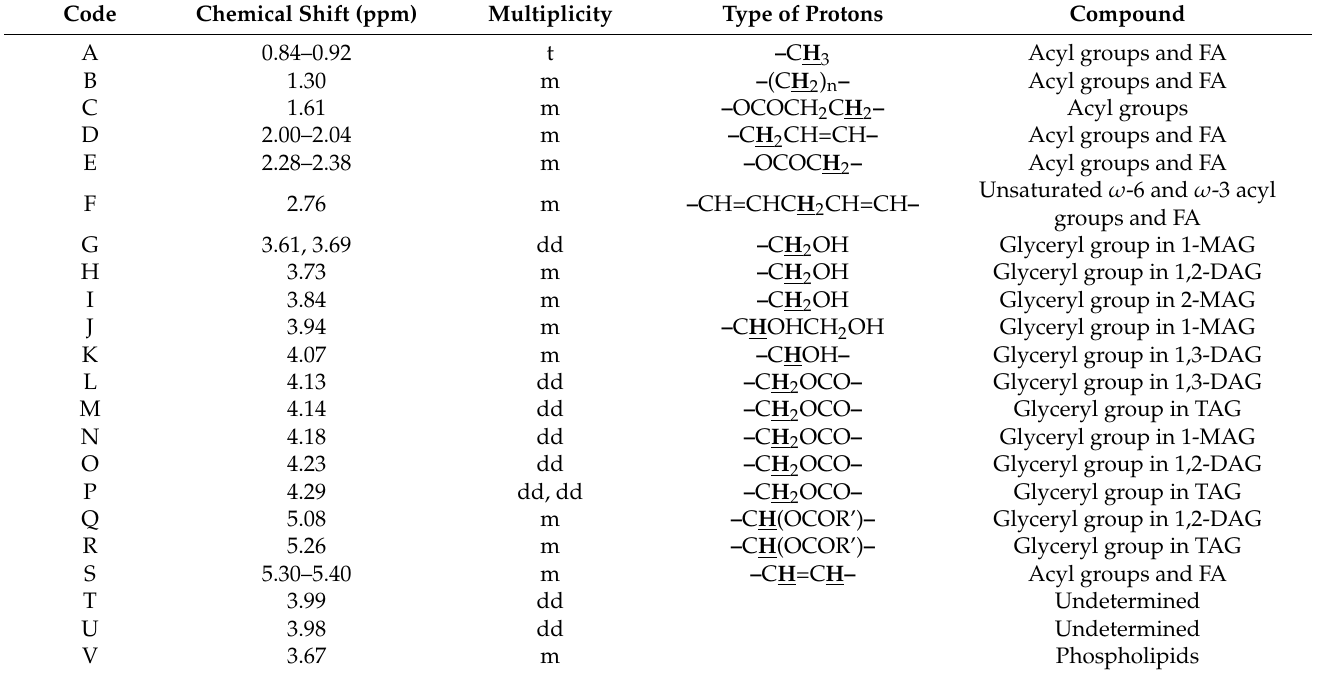
Table 3. Chemical shift assignments and multiplicities of the 1 H NMR signals of the main protons of glycerides and FAs present in